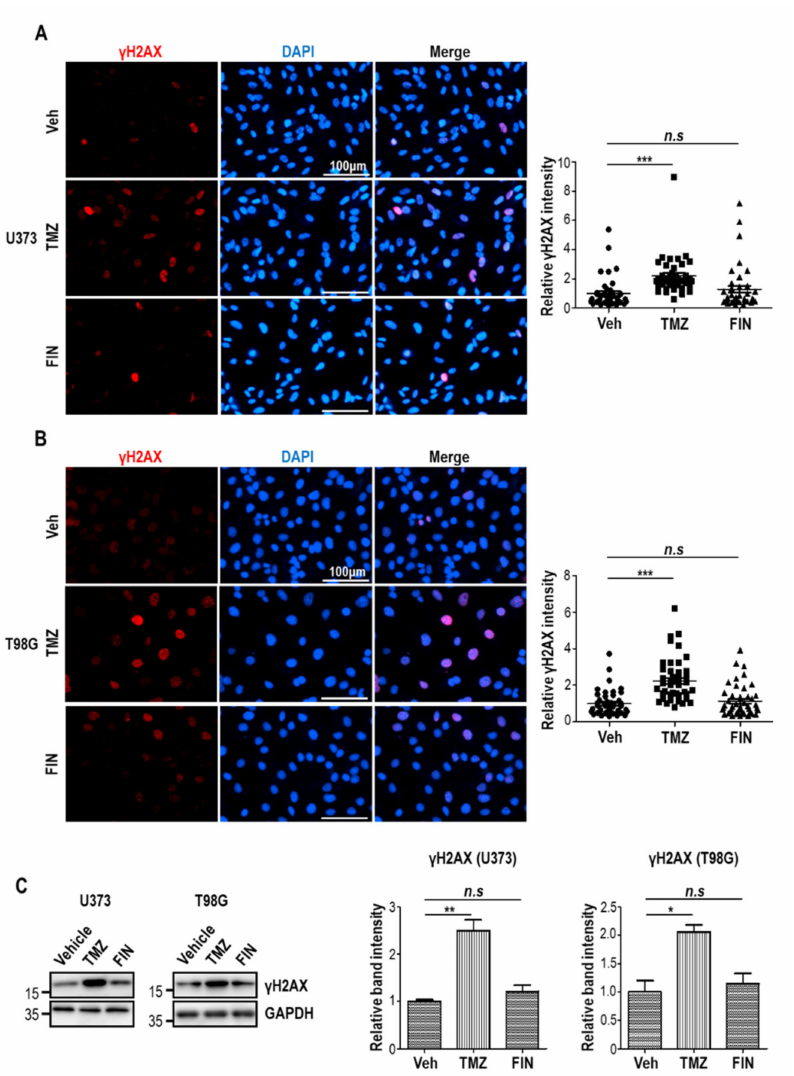
Figure 6. High-dose finasteride shows negligible effect on DNA damage in glioblastoma cells. (A and B) U373 ( A ) and T98G ( B ) cells were treated with DMSO or temozolomide (TMZ) or 100 µ M finasteride (FIN) for 24 h, and they were immunostained with a γ H2AX antibody (red). Nuclear DAPI staining is presented in blue (left). The relative signal intensities of γ H2AX are shown (right). Each dot means an individual cell. ( C ) Immunoblot analysis of γ H2AX in U373 (left) or T98G (right) cells upon treatment of DMSO or TMZ or 100 µ M FIN for 24 h. GAPDH was used as a loading control. The relative band intensities of γ H2AX are represented. The intensities of vehicle-treated samples were arbitrarily set to 1. * p < 0.05, ** p < 0.01, *** p <